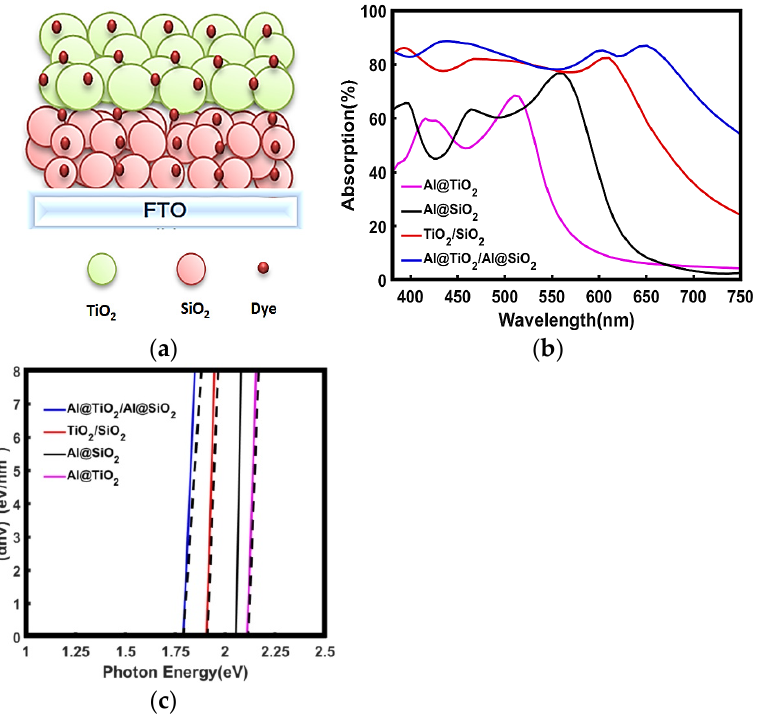
Figure 4. ( a ) Composite bilayer structure of photoanode based on aluminum-free spherical-shaped TiO 2 /SiO 2 ; ( b , c ) UV-Vis absorption spectrum and Tauc curve for band-gap calculation of photoanodes based on composite materials.